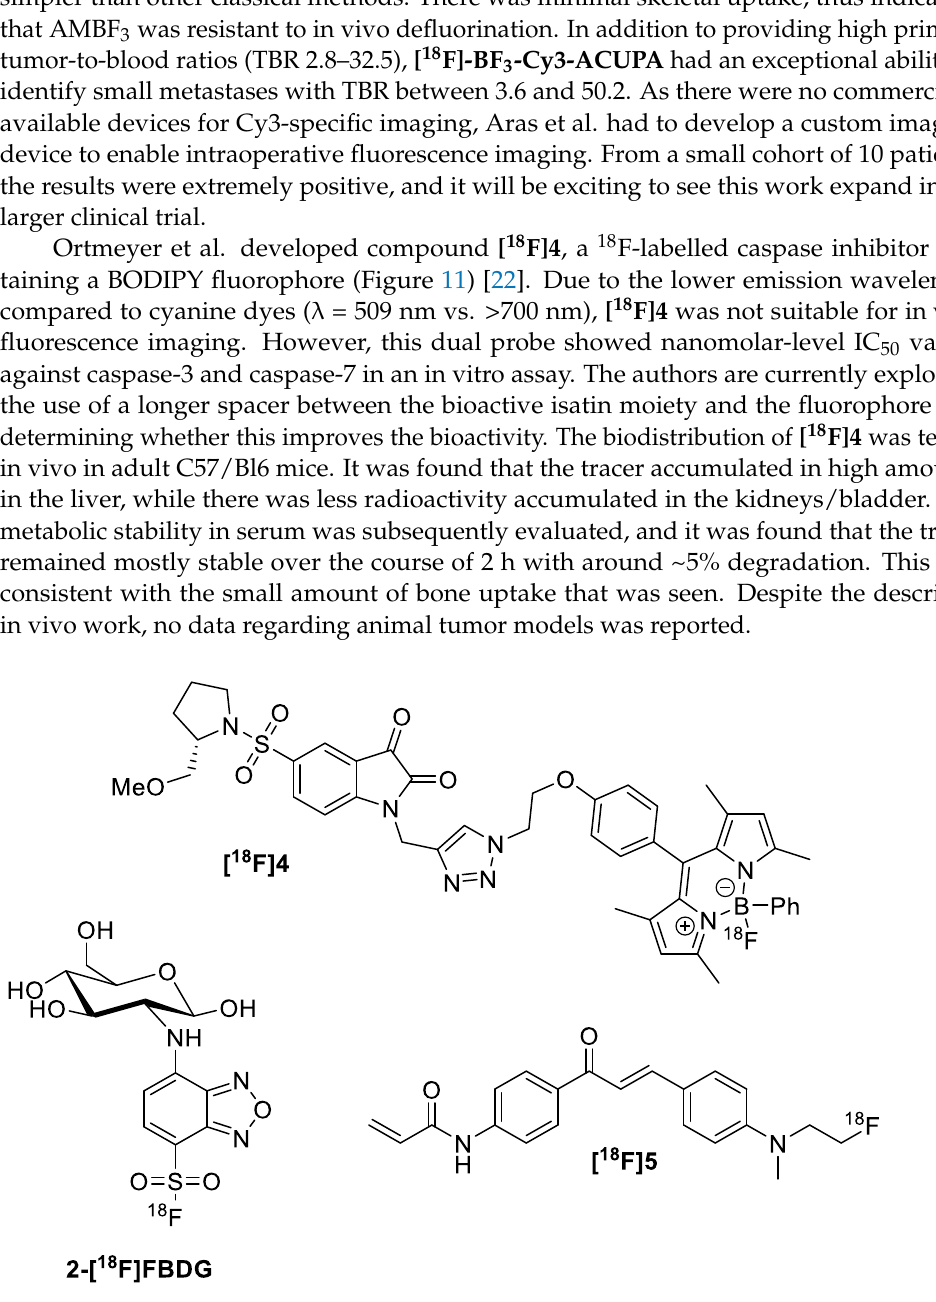
Figure 11. Non-cyanine-based small molecule dual probes: [ 18 F]4 , [ 18 F]5 , and 2-[ 18 F]FBDG